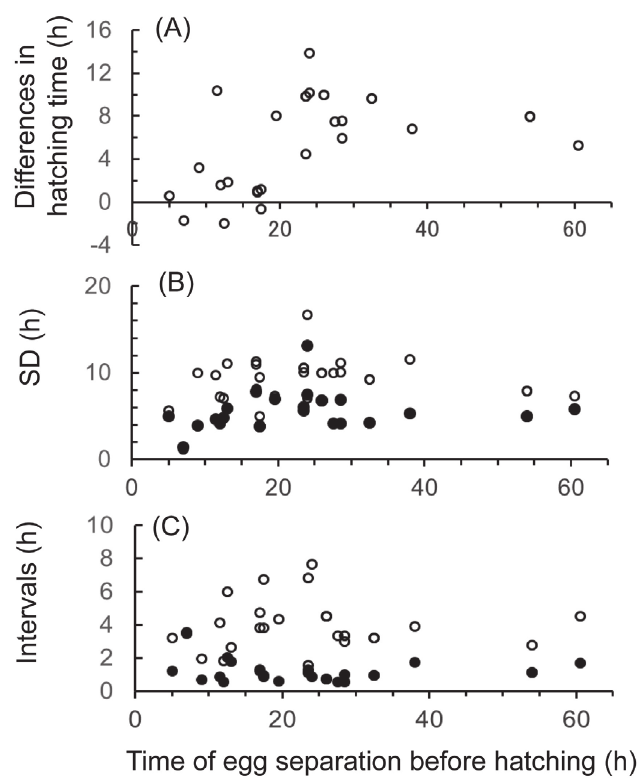
Fig. 8. The effect of the time of separation of paired Locusta mi- gratoria eggs on the hatching time. The differences in mean hatch- ing times between eggs separated and those kept in contact with each other (controls) are plotted against the time of egg separa- tion gauged based on the mean hatching time for the control eggs ( A ). Comparison of SDs of the mean hatching times ( B ) and the intervals of hatching in each pair ( C ) for the eggs separated (open circles) and the control eggs (closed circles). Each datum point is based on 14–24